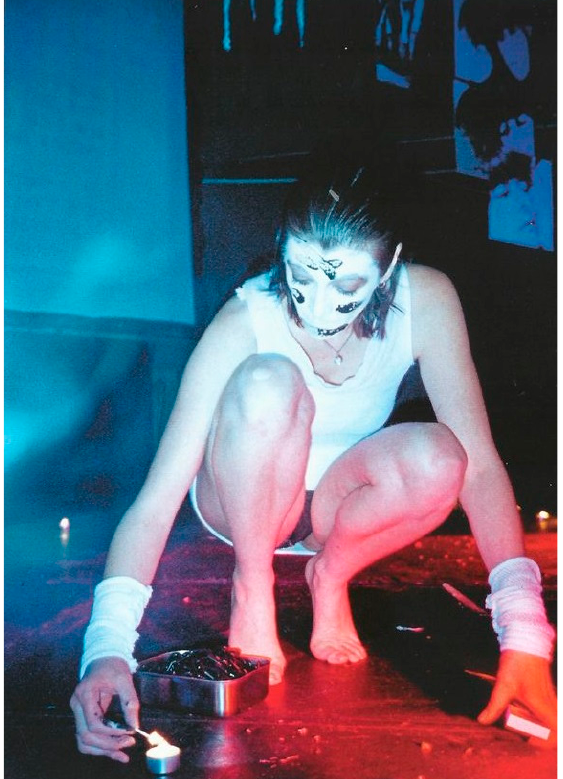
Figure 1. Cosey Fanni Tutti, Ritual Awakening Part 2 , performance, “Bar Europa” Festival, Amsterdam, 1987.